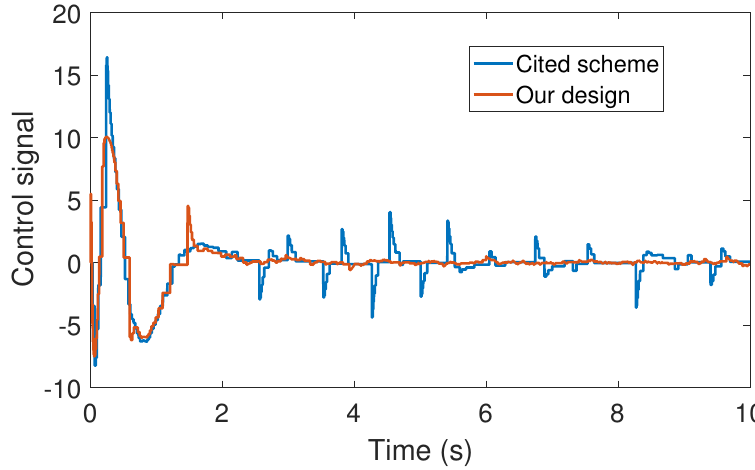
Figure 9. Numerical experiment results(noisy case): control signal (N).